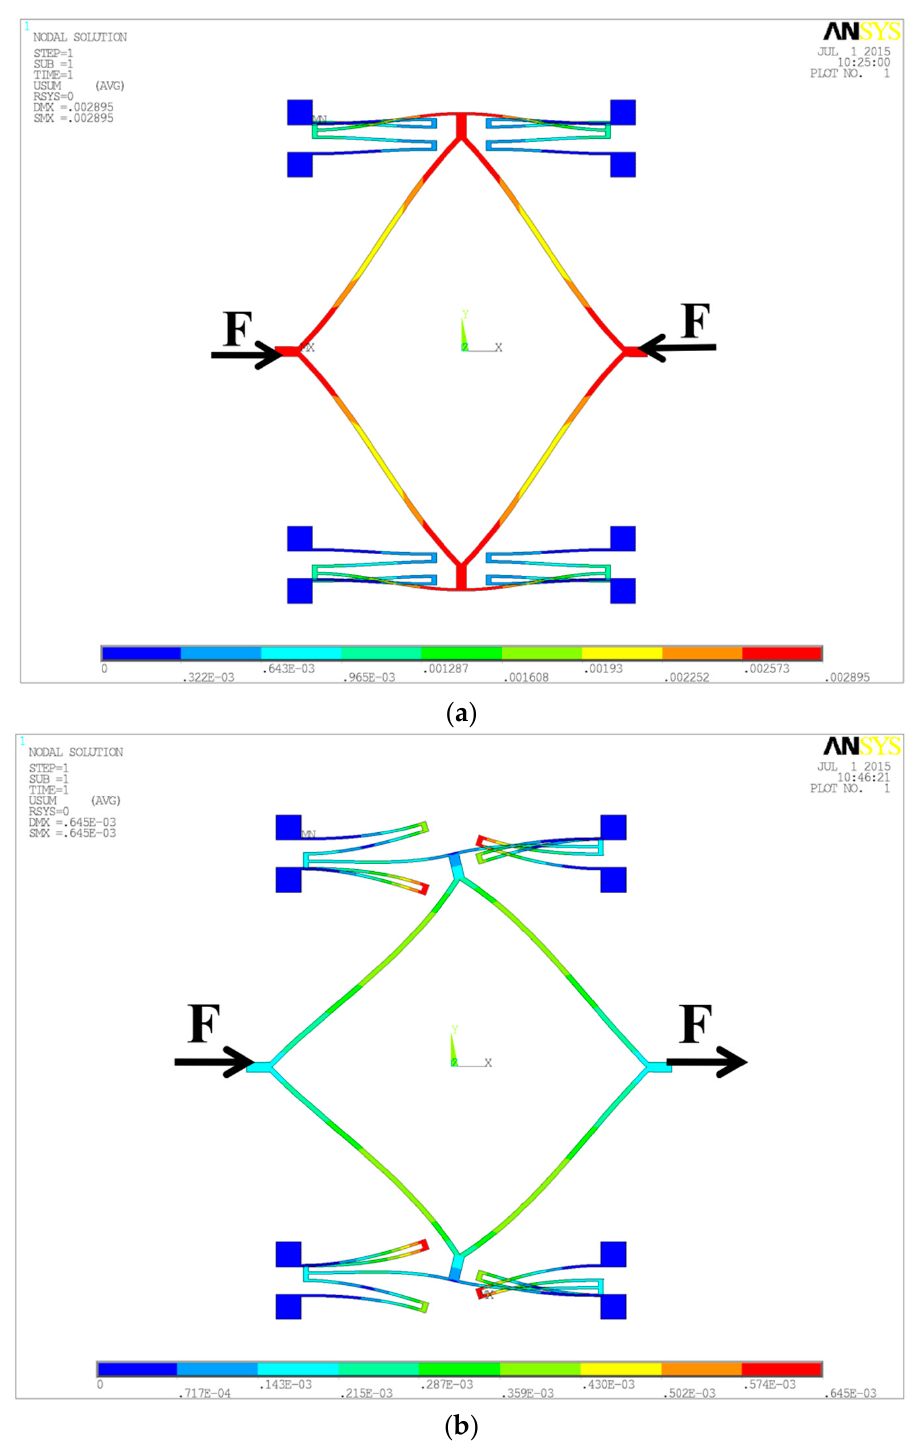
Figure 5. The stiffness of the anchored diamond coupling beam in the anti-phase mode ( a ) and in-phase mode ( b ).